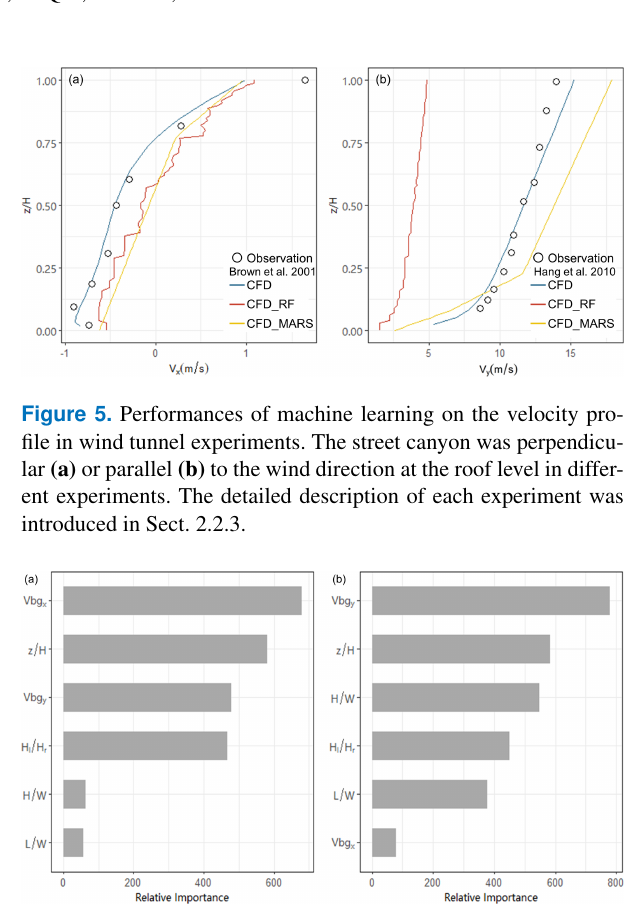
Figure 6. Variable importance ranking in the RF model for (a) V x and (b) V y